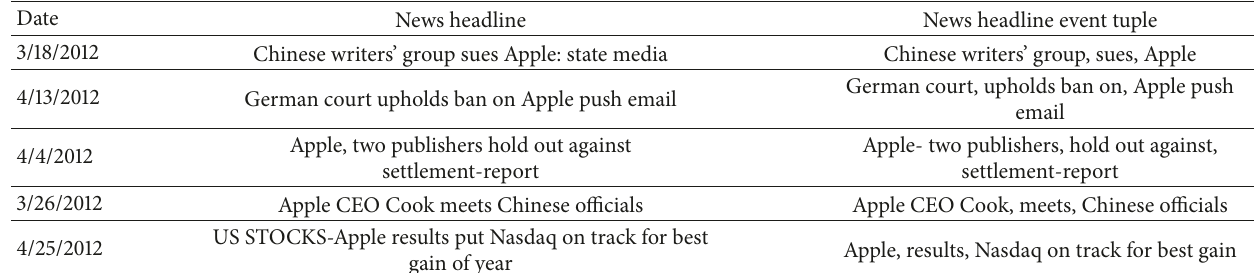
Table 3: Samples extracted from the